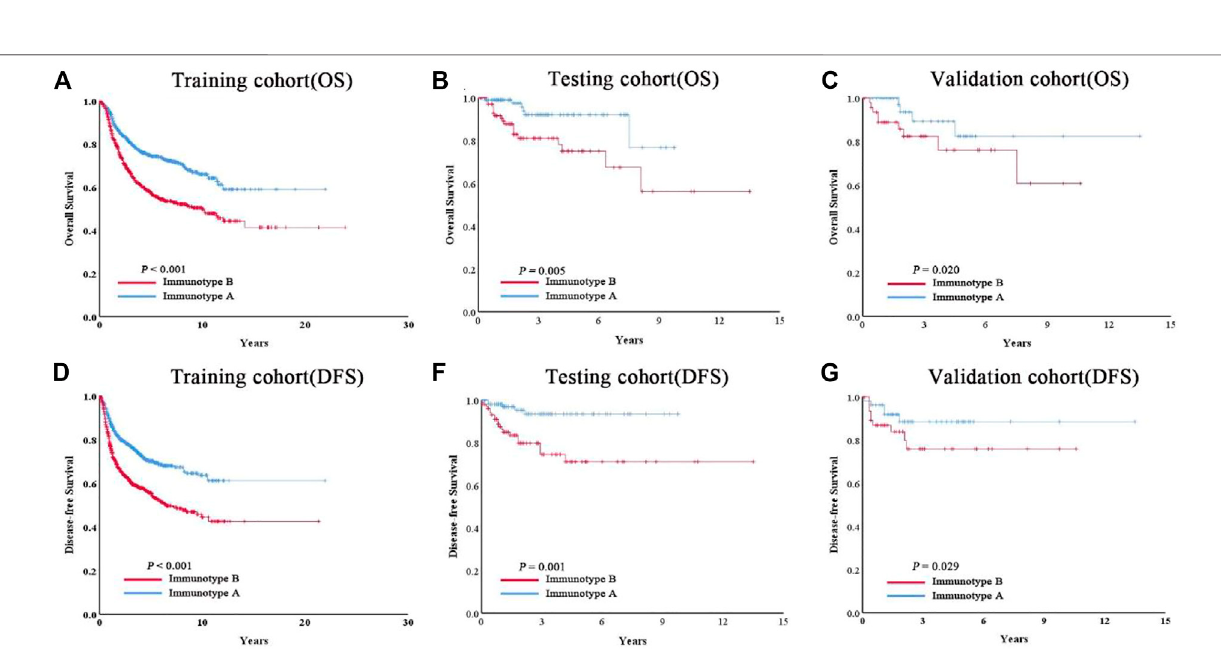
Frontiers in Molecular Biosciences |